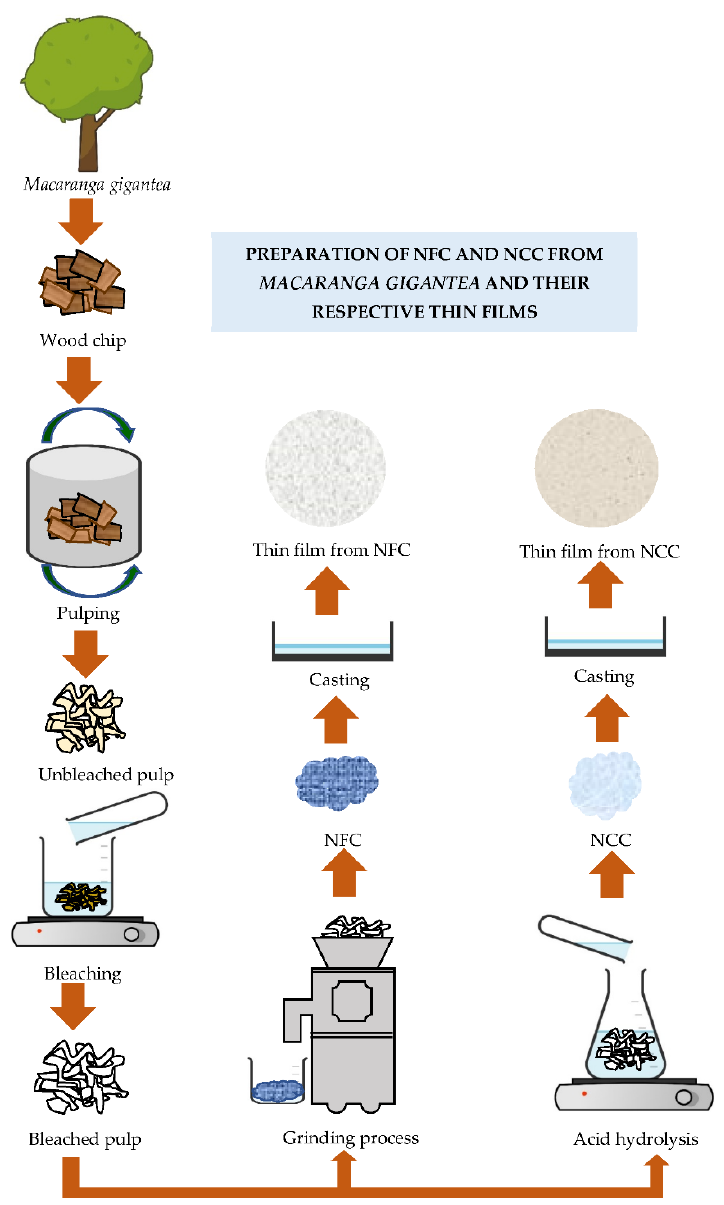
Scheme 1. Schematic diagram for the preparation of NFC and NCC from raw material i.e.,